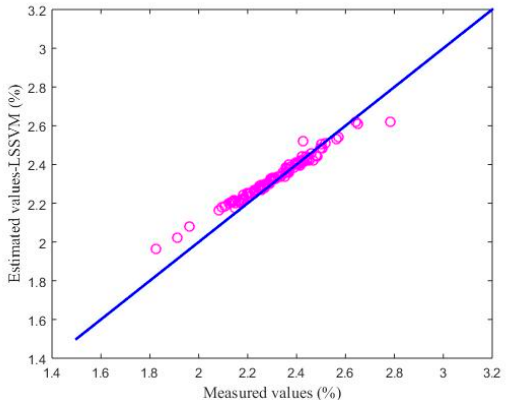
Figure 8. Comparison between the soft sensor based on a BP neural network and laboratory measurements.